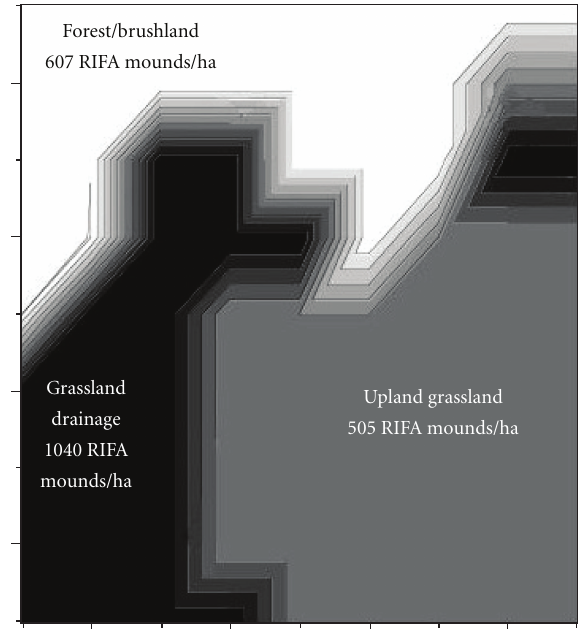
Figure 1: Placement of three macrohabitat types in the study area (measured by Waer and Grant (unpublished) in March 1989) with estimated red imported fire ant (RIFA) mound density for